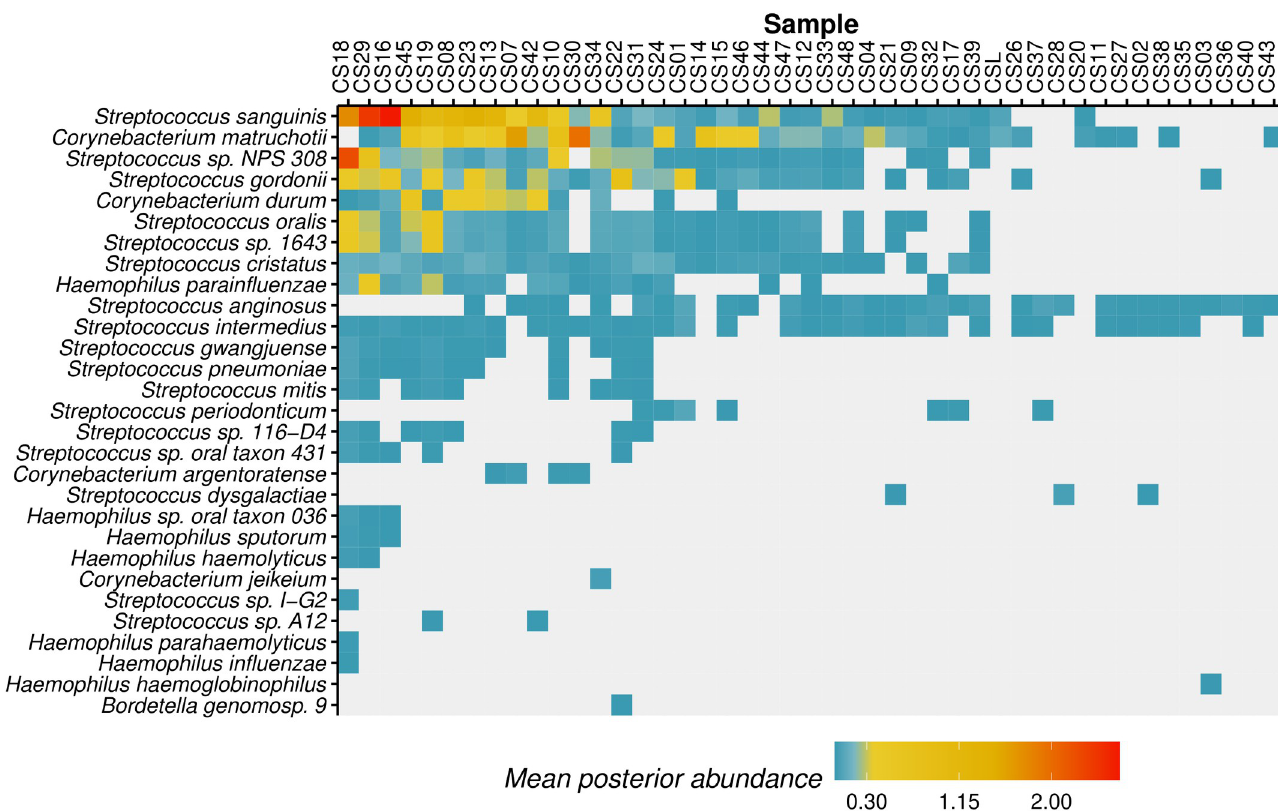
Fig 9. Posterior abundances of oral microbiome species in Case Study 2. Heatmap showing the mean posterior abundances for the 44 dental calculus samples, based on a custom database that combined the prokaryotic representative RefSeq and pathobionts with complete genomes from the following 5 genera: Corynebacterium , Haemophilus , Klebsiella , Streptococcus , and Bordetella . Species from these five genera of interest that naturally colonise the oral cavity can be found in more samples and at higher abundance (e.g. C . matruchotii ) compared to pathobionts of the upper respiratory system (e.g. S . pneumoniae